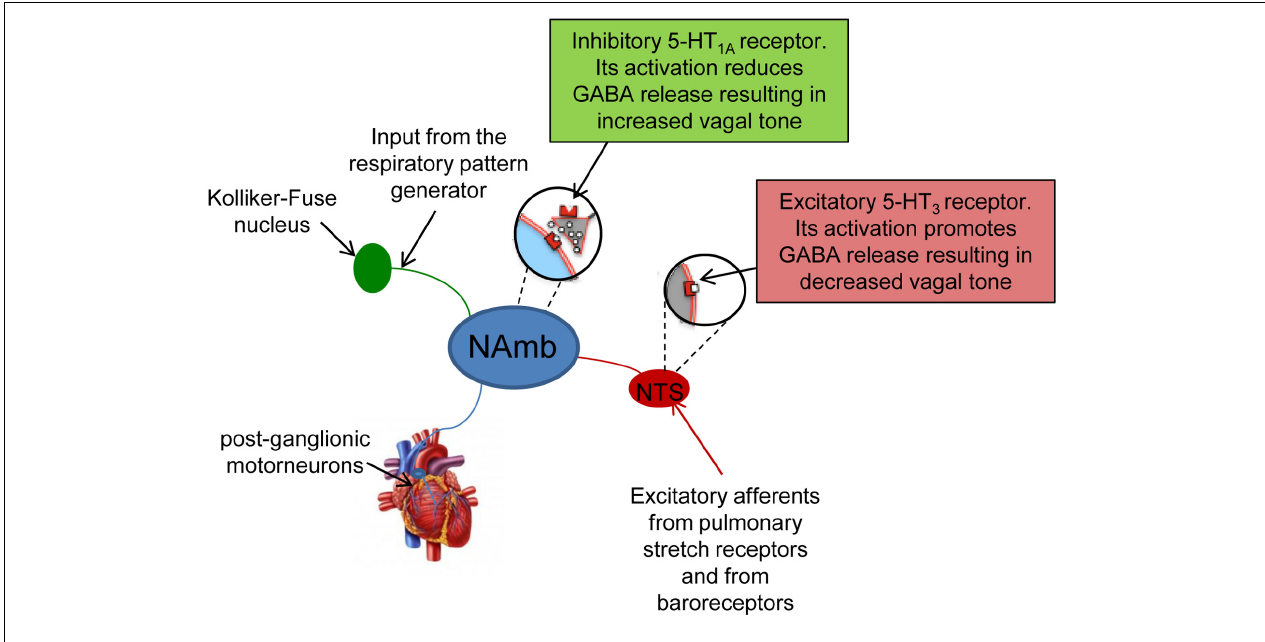
FIGURE 1 | Schematic representation of the origin and components of cardiac vagal pathway. Vagal activity is generated by preganglionic vagal neurons in the nucleus ambiguus (NAmb), which are tonically active. They receive phasic respiratory-related